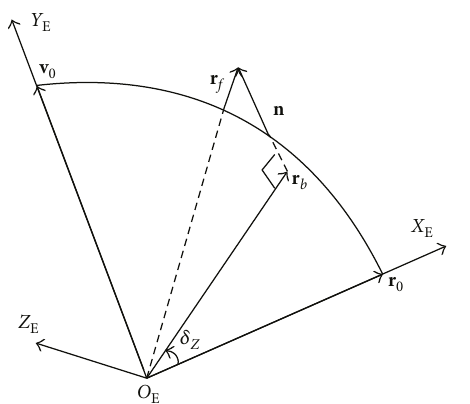
Figure 5: The schematic diagram of the reentry downrange.